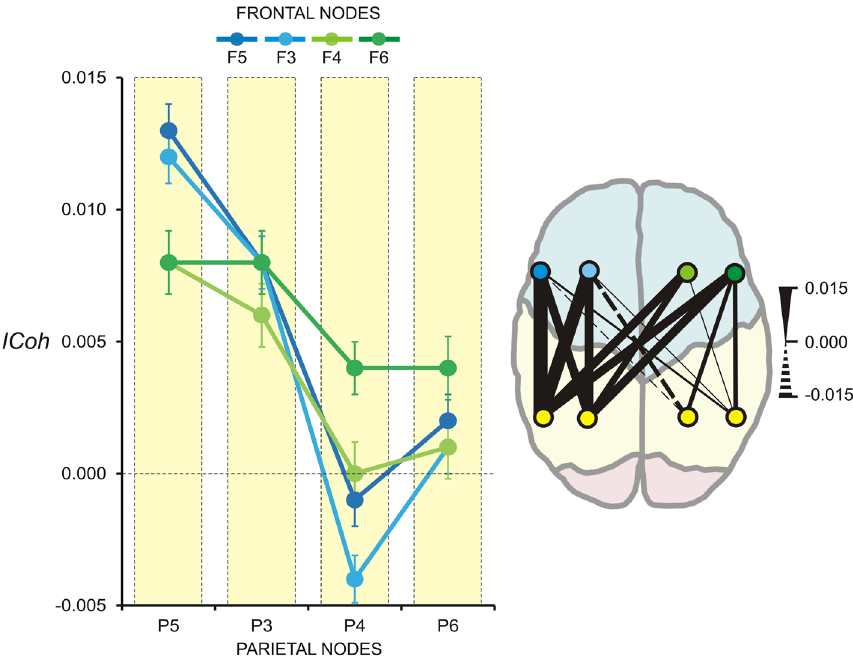
Figure 2. Connectivity of fronto-parietal theta networks during meditation. Left: Group mean ± SE of ICoh difference (meditation minus rest) in the theta frequency band (4–7 Hz); FAM, OMM and LKM pooled together. ICoh difference for each fronto-parietal electrode pair is presented, e.g., P5-F5, P5-F3, P5-F4, P5-F6, etc. Parietal nodes P5, P3, P4 and P6 are marked in yellow—X-axis, whereas the frontal nodes are in different colours as indicated in the figure (F5, F3, F4, F6). Y-axis—non-dimensional ICoh difference values. Right: Graphical presentation of same results. Thickness of connections codes the value of ICoh difference, as indicated. Colours of nodes correspond to the colours used to denote parietal and frontal electrodes in the left panel. The meditation-related intra-hemispheric increase in theta- ICoh in the left hemisphere, common to FAM, OMM and LKM, is